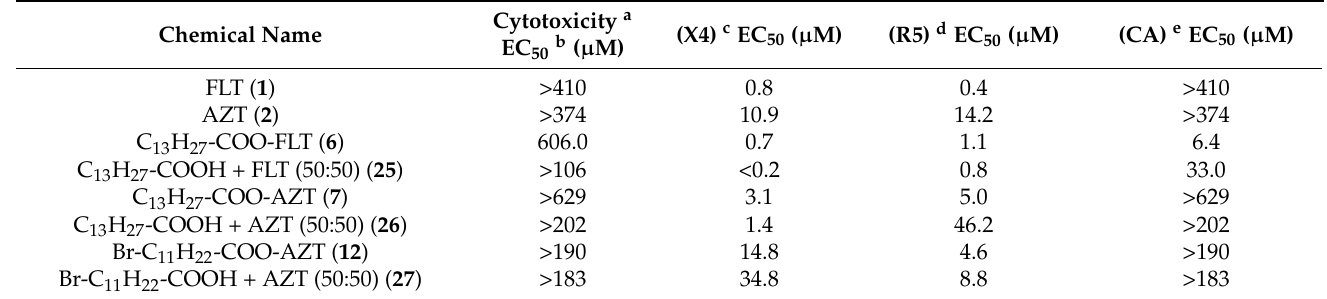
Table 3. Comparison of the anti-HIV activities of fatty acyl derivatives of AZT and FLT with the corresponding physical mixtures of AZT or FLT + fatty acids.